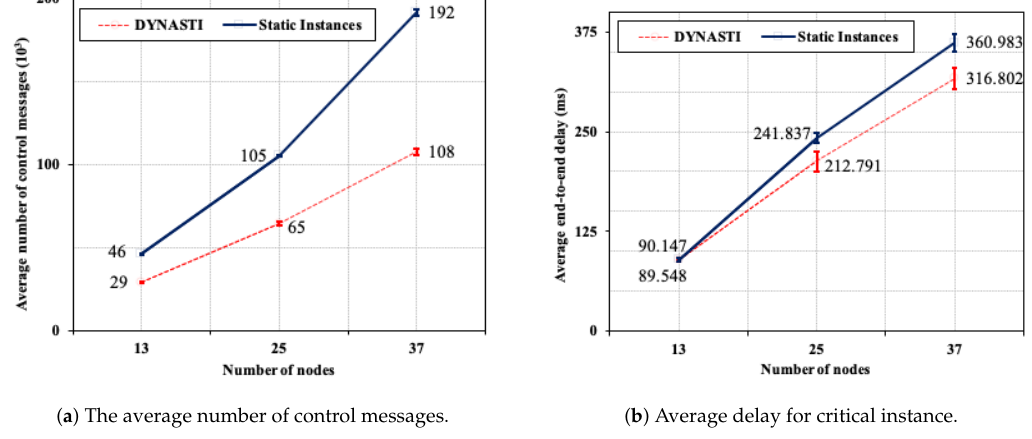
Figure 8. The average number of control messages and average delay for critical instance.